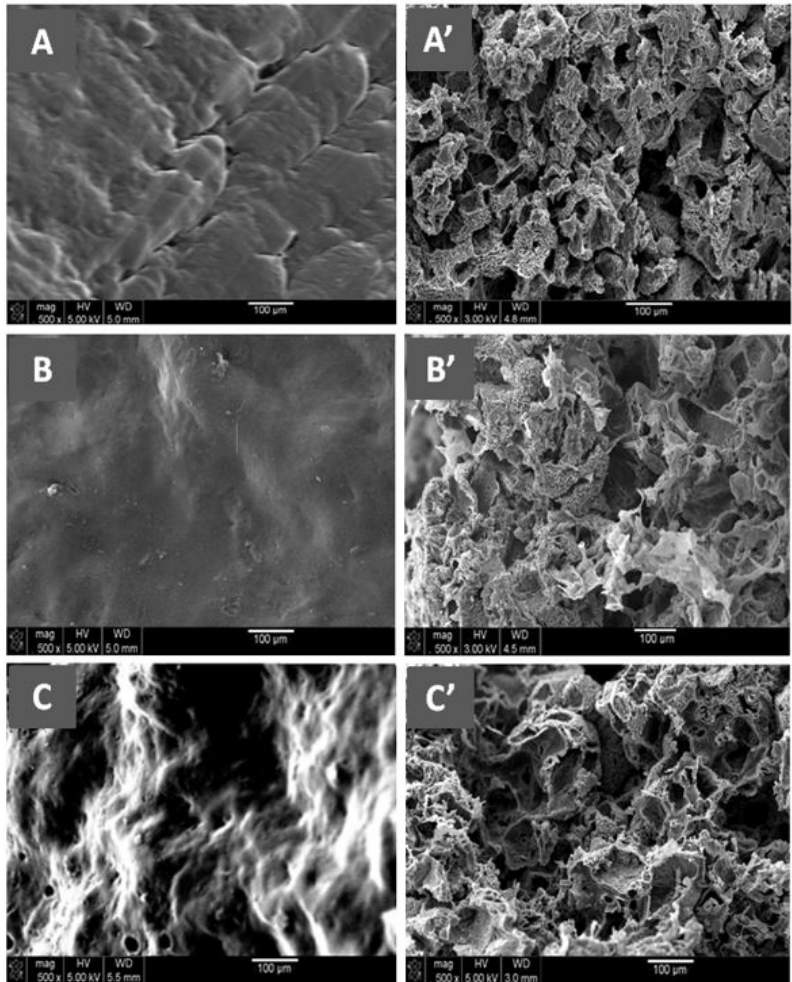
Figure 12. (Left) SEM micrographs of the surface morphologies of Naph microparticles embedded with ( A ) E-VAL, ( B ) PCL and ( C ) E-VAL / PCL25. (Right) the cross section morphologies of ( A’ ) E-VAL, ( B’ ) PCL and ( C’ ) E-VAL / PCL25 after removing Naph microparticles.